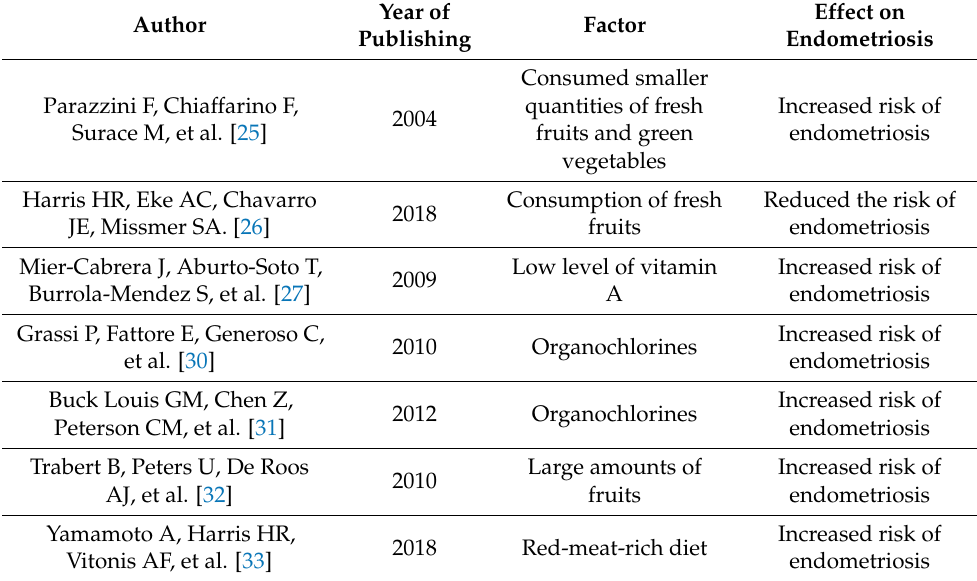
Table 2. Diet factors of